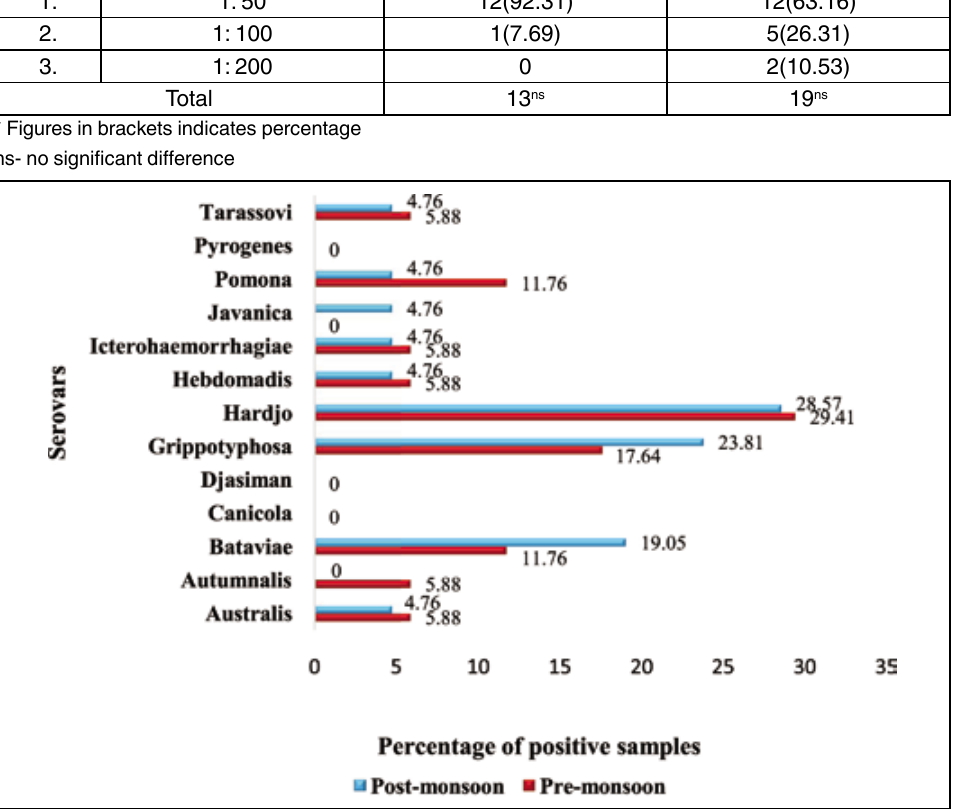
table 1. MAT antibody titre observed from dairy cattle sl. No